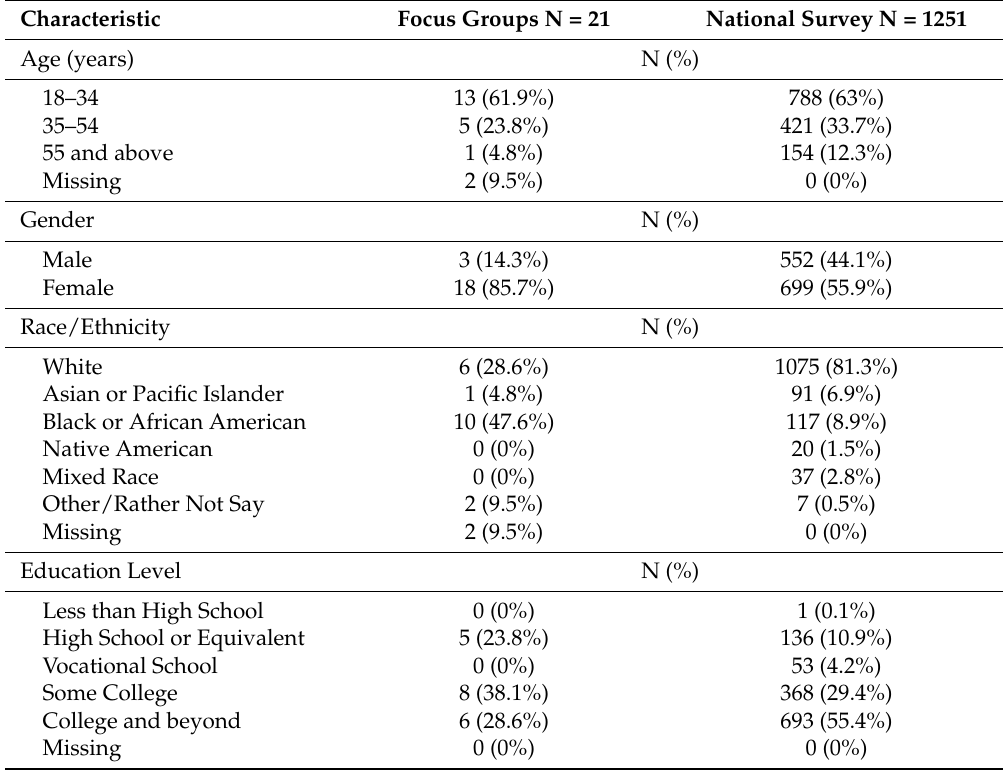
Table 1. Focus group participant demographic